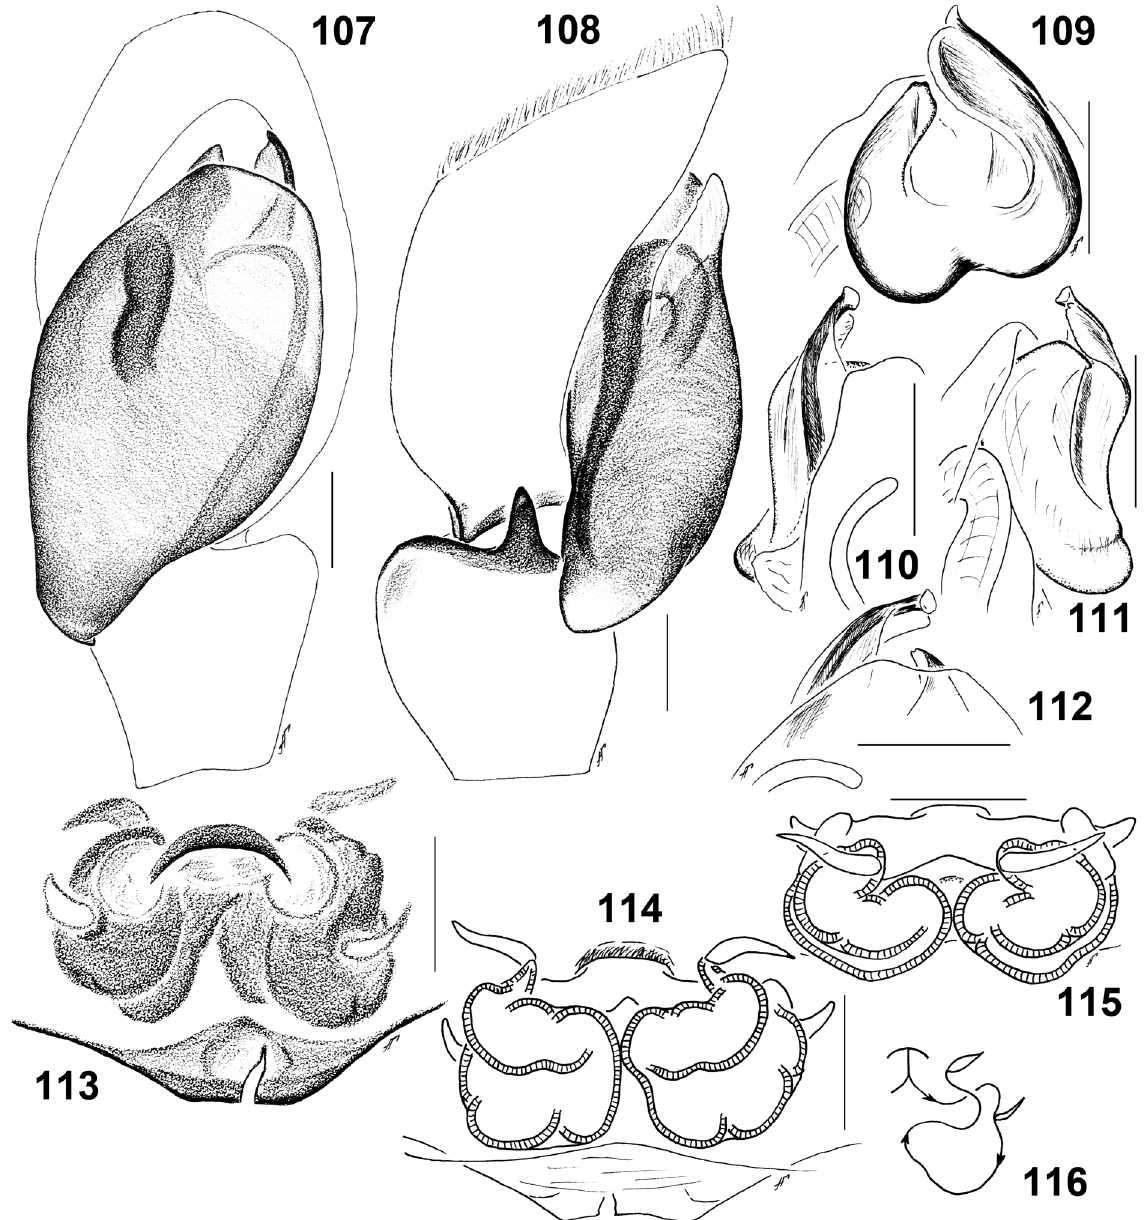
Figs 107–116. Manzuma lympha (Próchniewicz & Heçiak, 1994) gen. et comb. nov., holotype (107– 108), paratype (109–112) and ♀ from Gof Sokorte Guda (113-116). 107–108 . Male palp. 107 . Ventral view. 108 . Retrolateral view. 109–112 . Embolic division. 109 . Dorsal view. 110 . Prolateral view. 111 . Retrolateral view. 112 . Ventral view. 113 . Epigyne, ventral view. 114–115 . Spermathecae. 114 . Dorsal view. 115 . Apical view. 116 . Diagrammatic course of the insemination ducts. Scale bars: 0.1